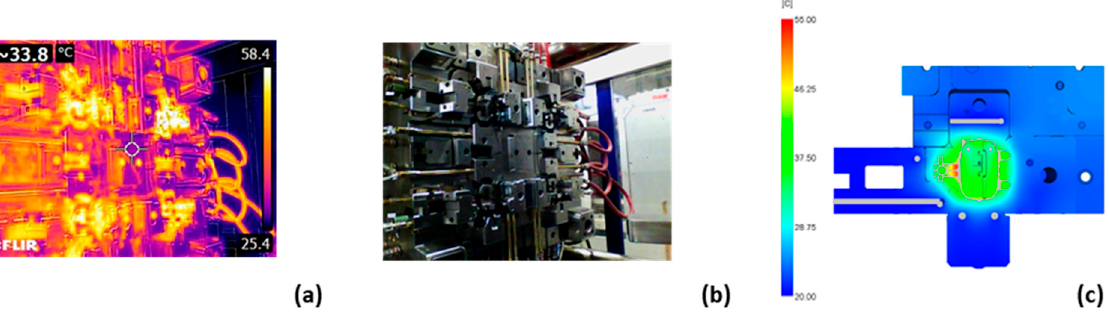
Figure 13. The thermal image of the tool reveals local overheating ( a ), the corresponding photo of the tool ( b ), and the tool temperature simulation results ( c ).